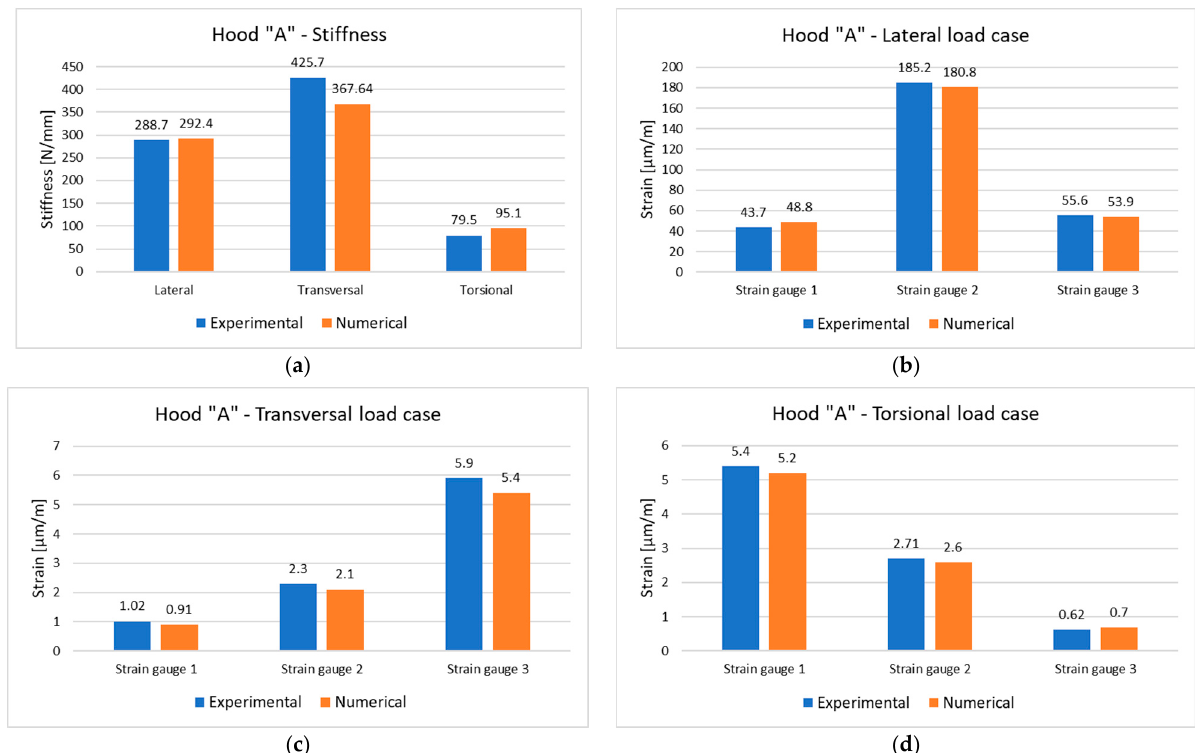
Figure 18. Comparative analysis of experimental and numerical (simulated) values for the composite hood “A”: ( a ) stiff- nesses; ( b ) strains in lateral load case; ( c ) strains in transversal load case; ( d ) strains in torsional load case.